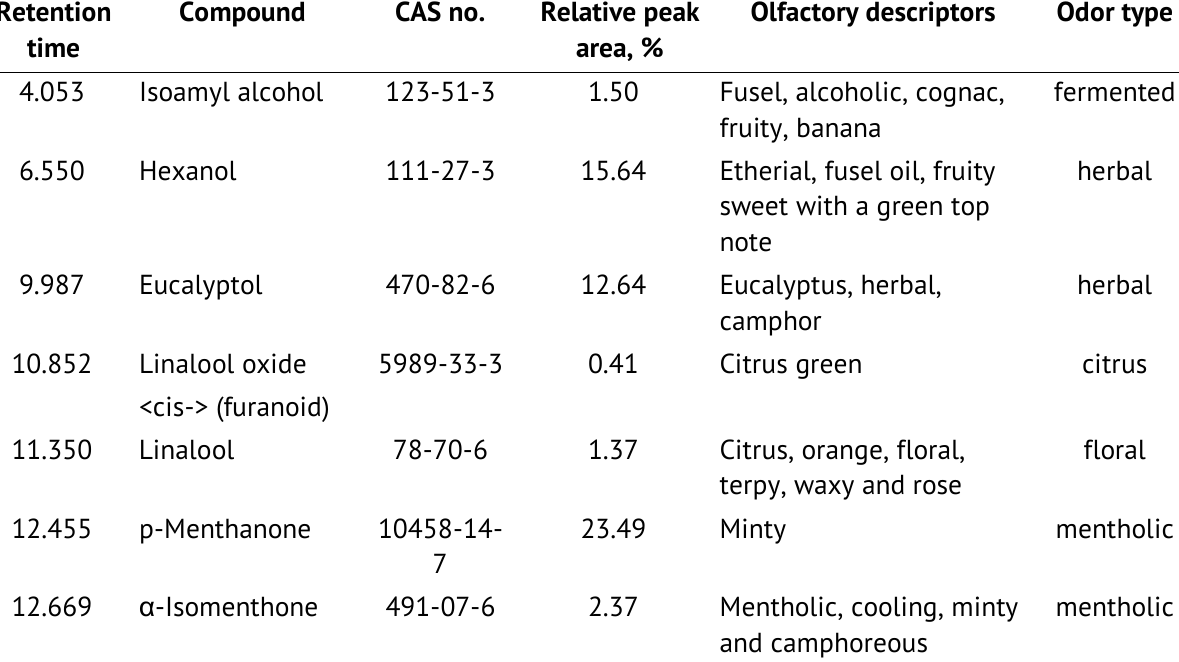
Main volatile compounds found in Viorica grapes juice: GC/MS retention data, compound identification, CAS number [19] and olfactory